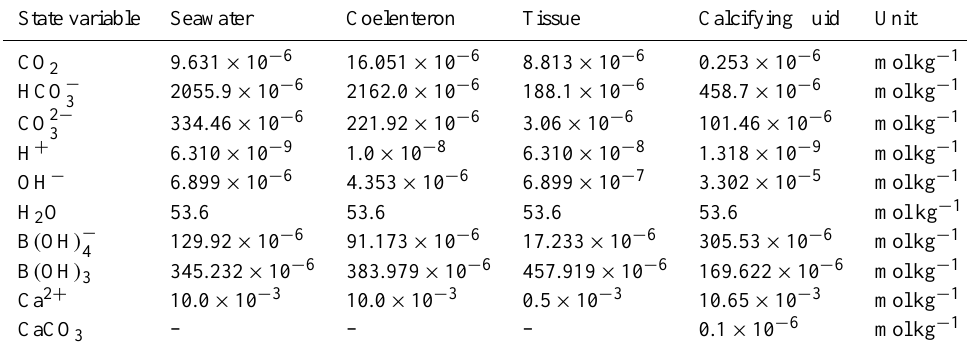
Table 1. Initial concentrations of state variables.